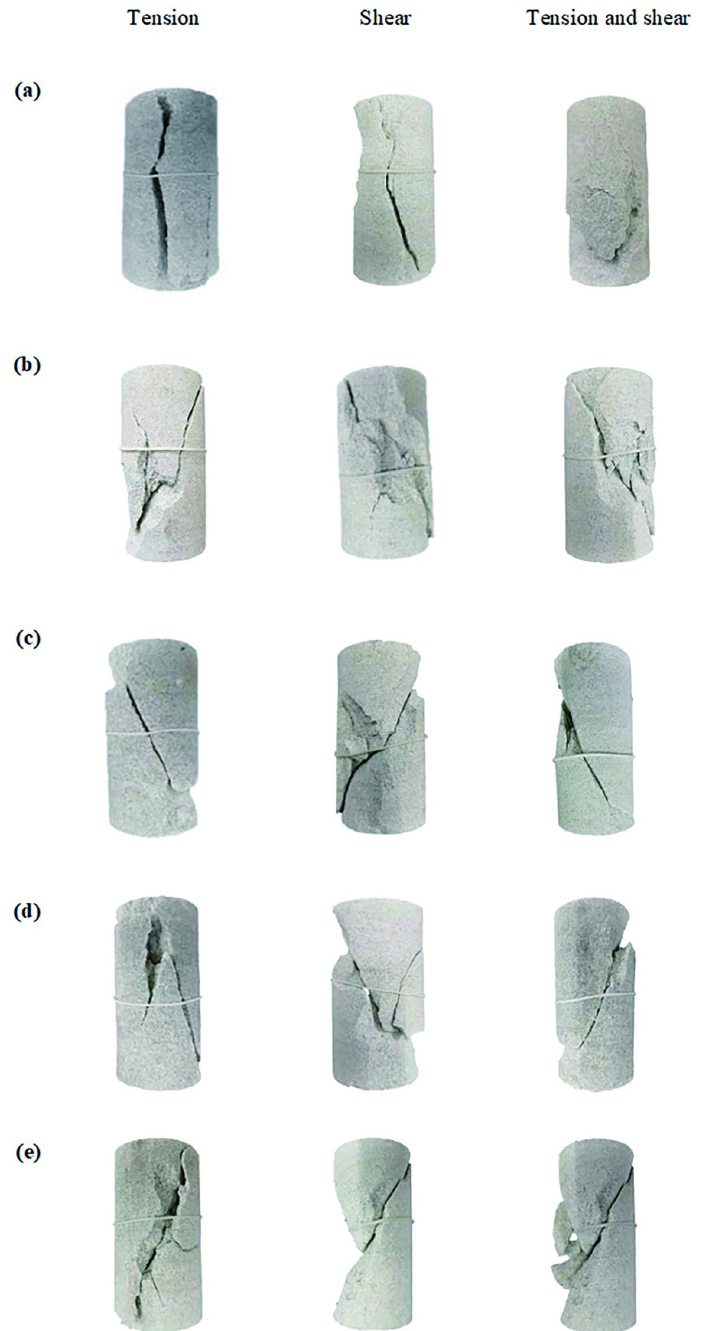
Fig 25. Failure mode of the test piece for raw rock. (a) 20˚C. (b) 40˚C. (c) 60˚C. (d) 80˚C. (e)